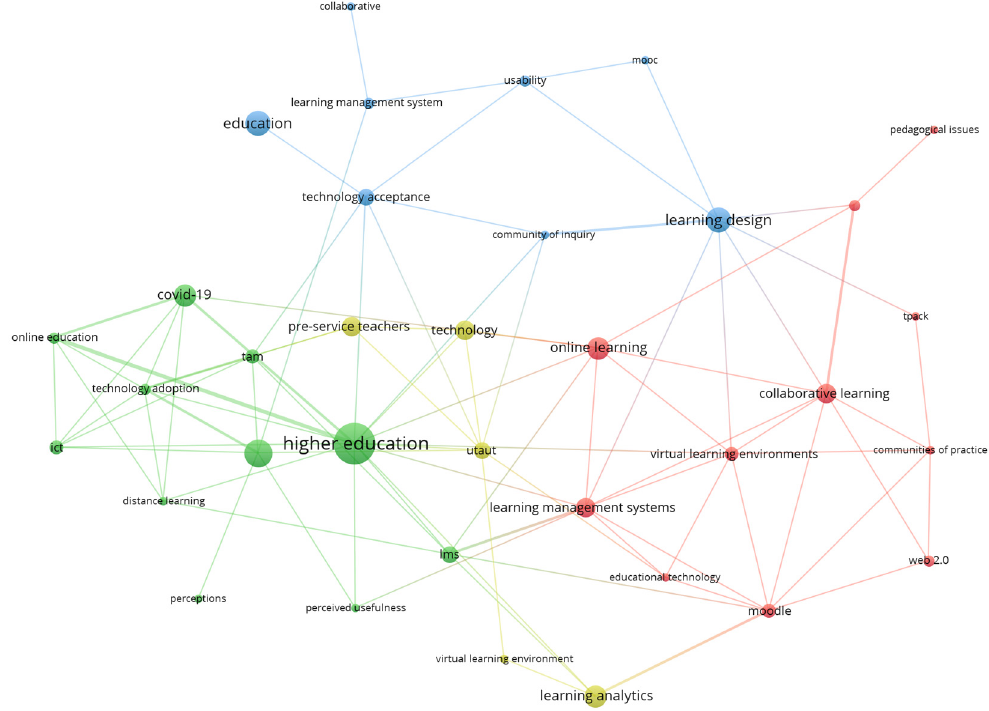
Figure 10. Keyword co-occurrence network. Own elaboration.